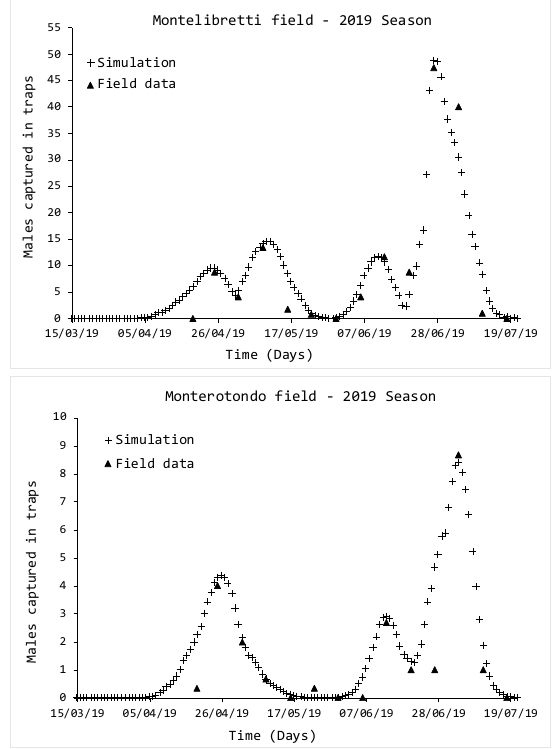
Figure 4. Comparison between simulated and monitored D. suzukii populations, growing season 2019. Triangle indicators represent data from traps, while crosses indicate simulations.